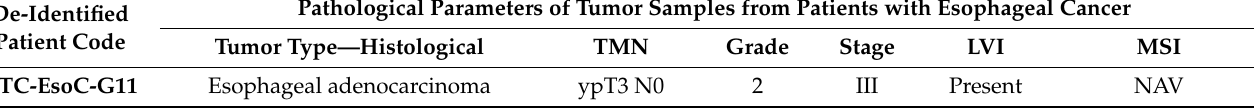
Table 3. Demographics of the patients whose blood samples were used for the study (F = Female; M = Male; BMI = Body Mass